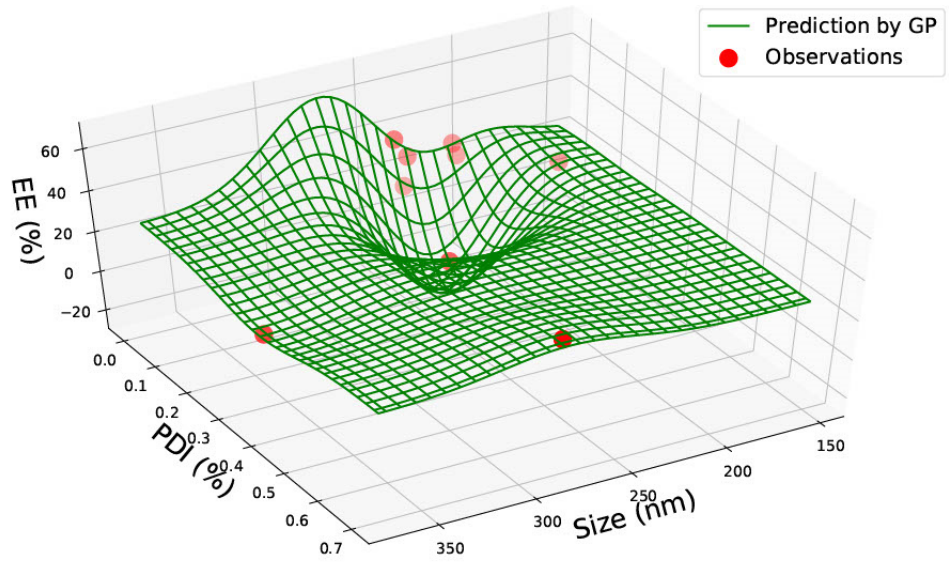
Figure 11. PLGA 85:15—graph representing size (nm), Polydispersity Index (PDI) and Encapsulation Efficiency (EE%).